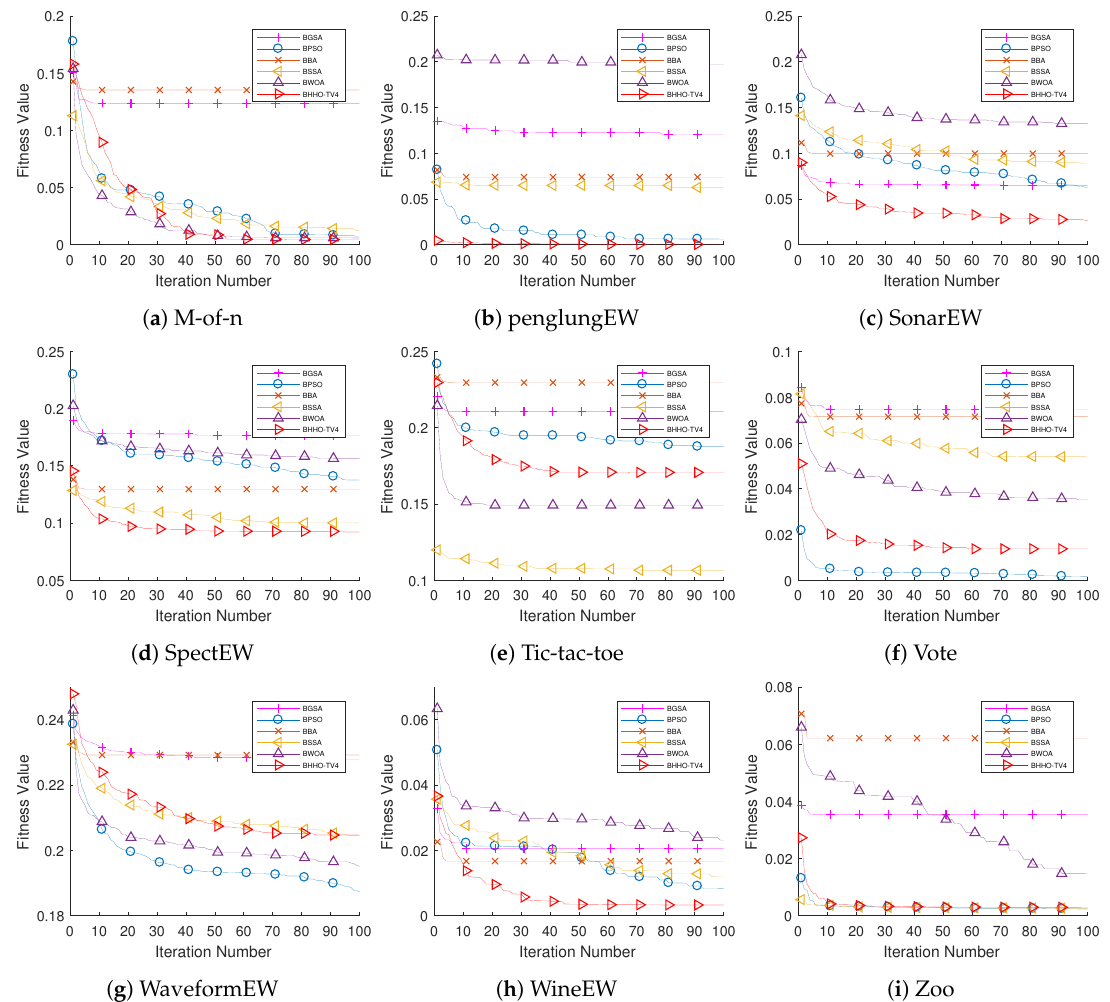
Figure 5. Convergence curves of BHHO TV 4 versus other competitors on M-of-n, penglungEW, SonarEW, SpectEW, Tic-tac- toe, Vote, WaveformEW, WineEW, and Zoo